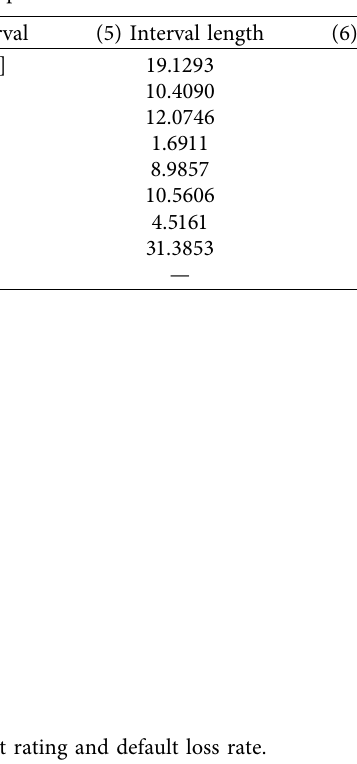
Table 5: Credit rating results of small enterprises.